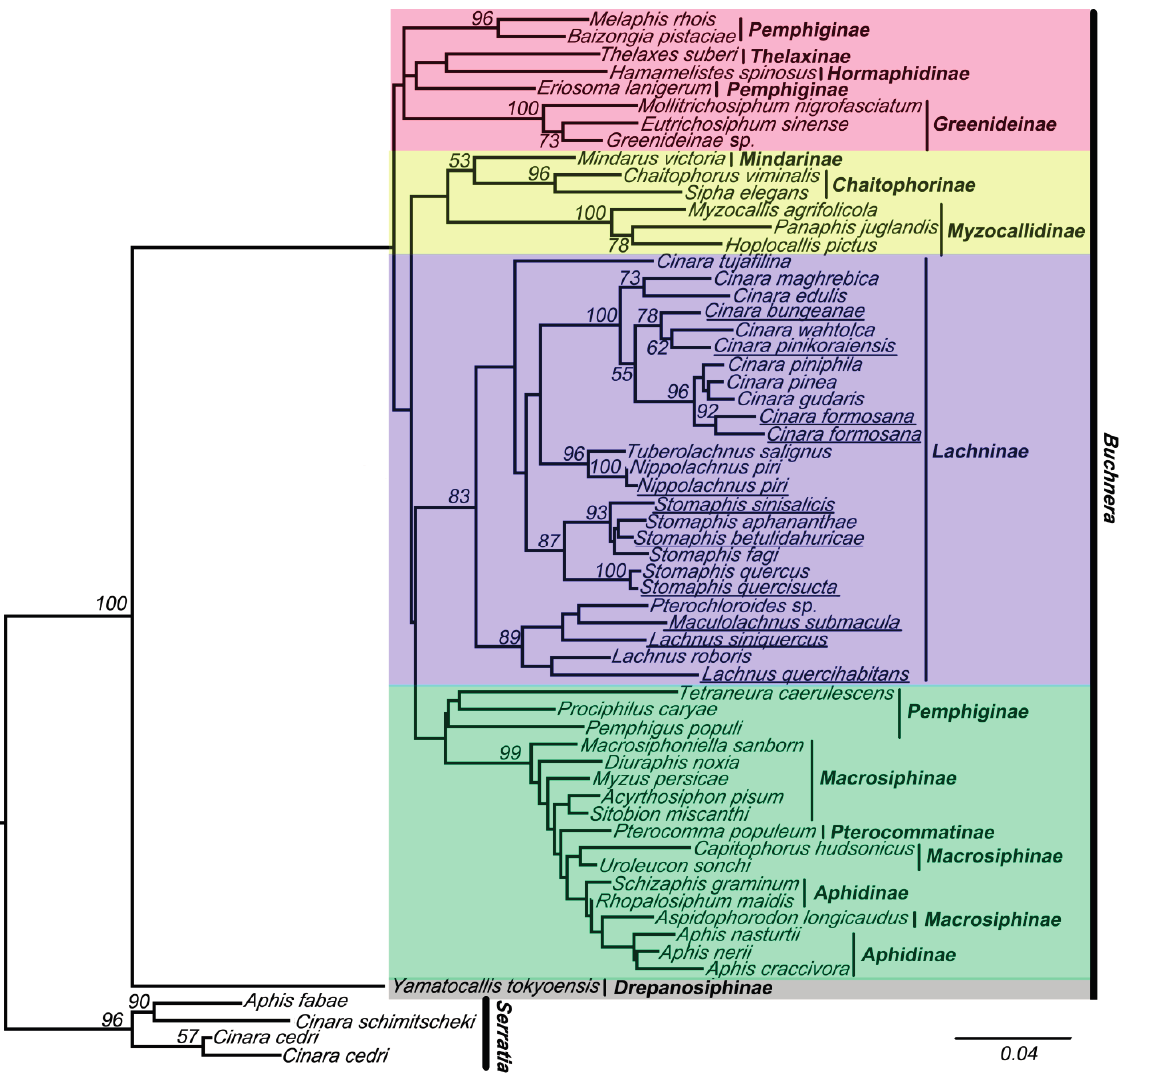
Figure 2. The maximum likelihood (ML) phylogenetic tree inferred from data-set I (without chimeric sequences). Buchnera sequences are represented by the names of their host species. The sequences obtained from this study are underlined. The nodes are marked by their ML bootstrap values. The bar represents 4% of sequence change with regard to the likelihood distance. The underlined species are with chimeric